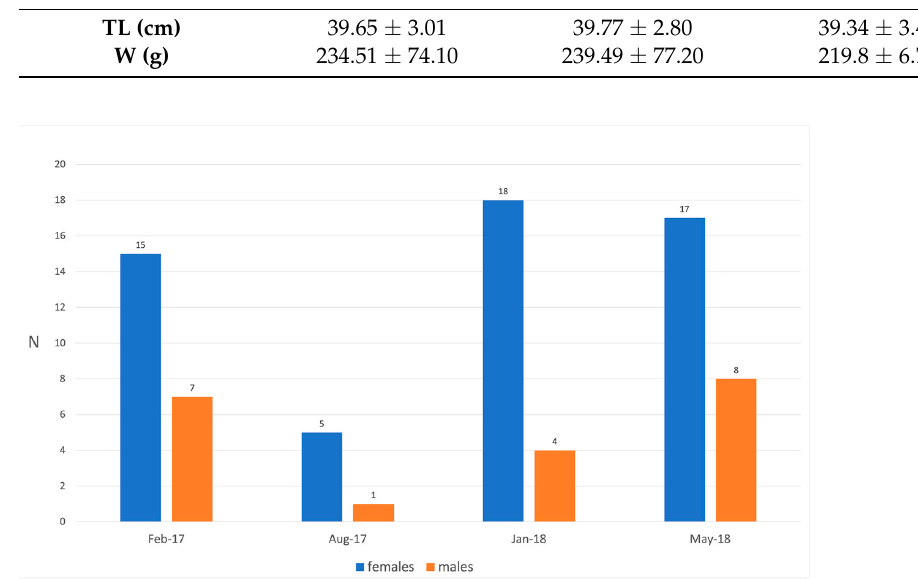
Figure 3. Frequency histogram of the numbers of specimens collected by month and by sex.